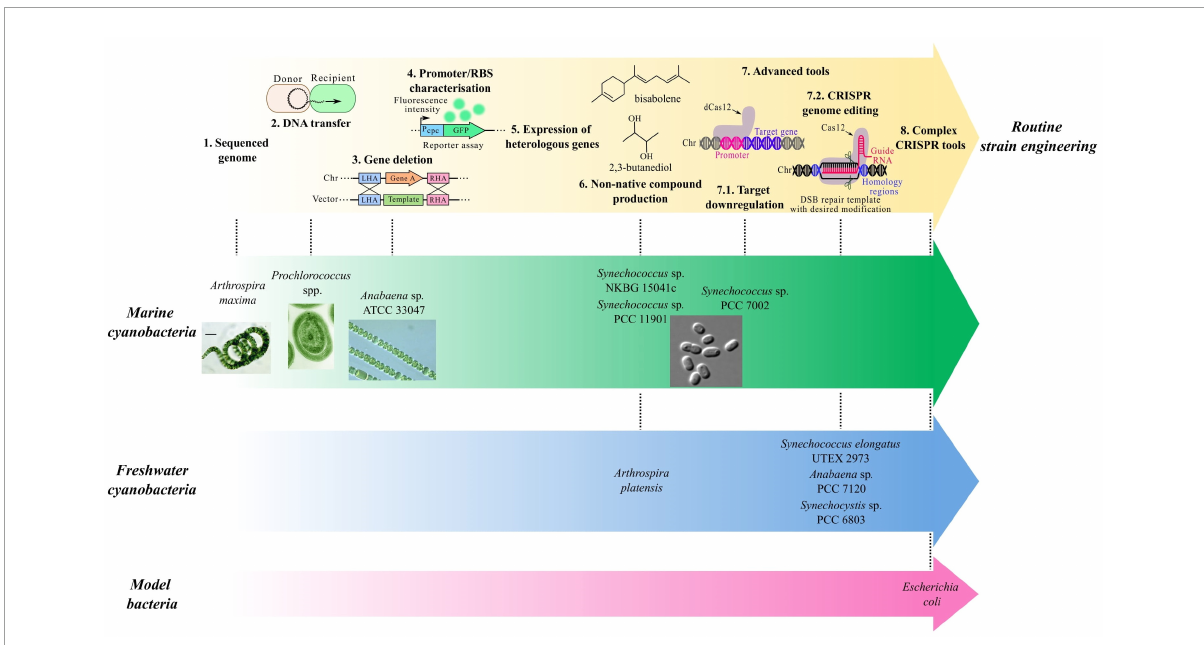
FIGURE1 Progression of genetic tools toward routine strain engineering. Most marine cyanobacteria remain at earlier stages of tool development while freshwater cyanobacteria and model organisms have more complex genetic tools available.